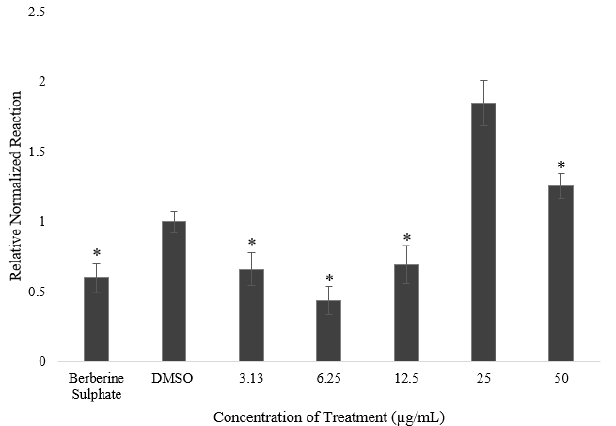
Figure 2. The effects of selected A. planci fraction on PCSK9 mRNA expression in HepG2 cells. Each value shows mean ± SEM of 3 replicates after the gene expression level of PCSK9 was normalized against that of β -actin, and the value of the untreated control was assigned as 1. The mRNA expression level of PCSK9 for each treatment is relative to the control value. DMSO was used as the carrier to dissolve and dilute the extract. Cells were treated with 1% ( v / v ) DMSO and berberine sulfate as the negative and positive controls, respectively. ‘*’ denotes statistically significance ( p < 0.05) as compared to untreated control.